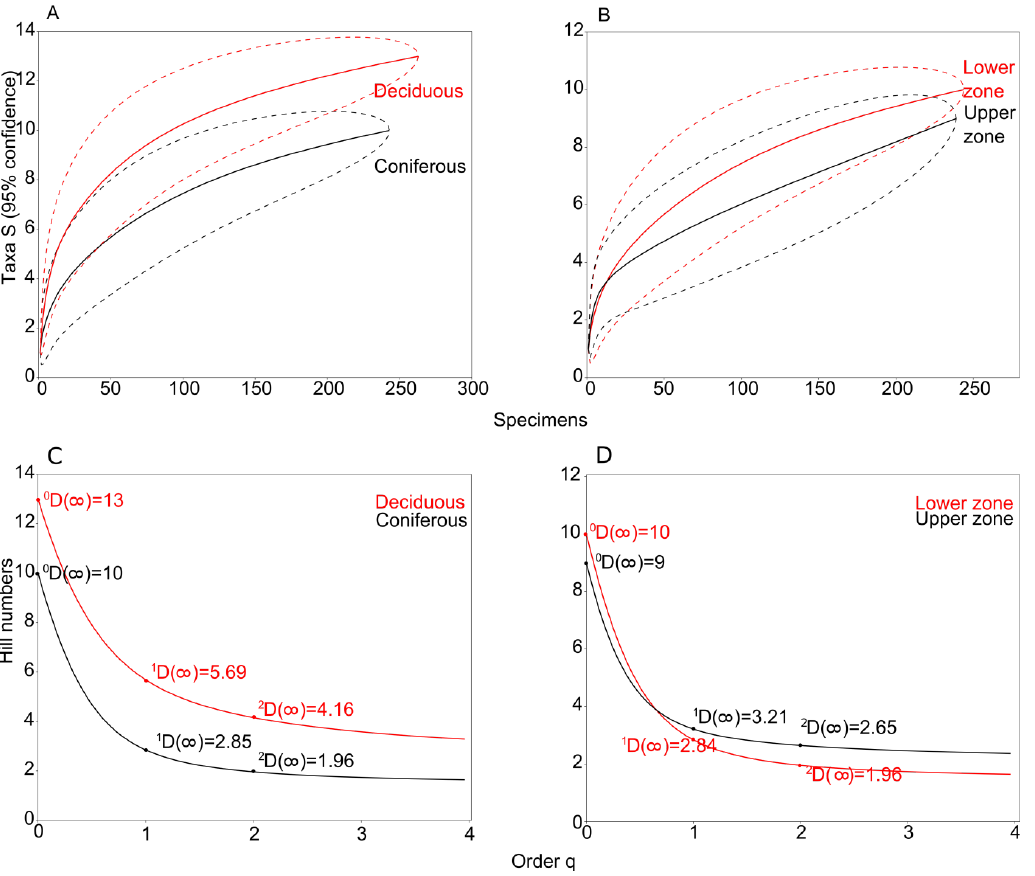
Figure 7. Dominance structure of bat assemblages recorded in the undisturbed and disturbed coniferous forests of the lower and upper zone in the Polish Tatra Mountains, 2016–2020. Used symbols: *species frequency significantly differed between forests p ≤ 0.05, X— lack of species. For species abbreviations see description of Figure 2.